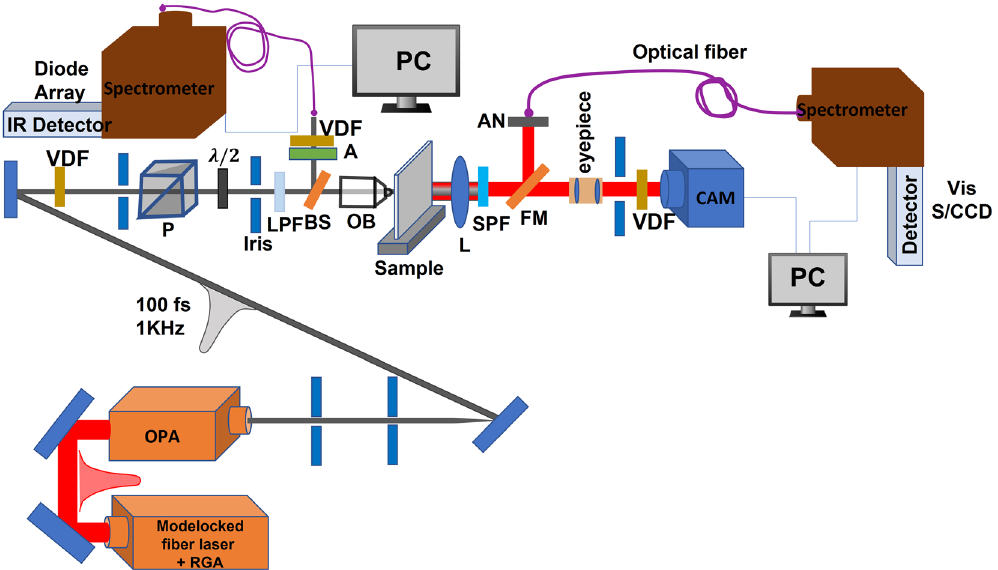
Figure 3: Schematics of the non-linear experimental set up for spectrally resolved second harmonic generation from Au-DRMs (OPA, optical parametric amplifier;S/CCD,spectrometer coupledwithchargecoupleddevices;A, attenuator;VDF,variable densityfilter;RGA, regenerative amplifier;CAM,infraredcamera;OB,objectivelens;L,lens;LPF/SPF, longpassfilter/shortpassfilter;FM,flipmirror;PM,powermeter;P/AN, polarizer/analyzer).